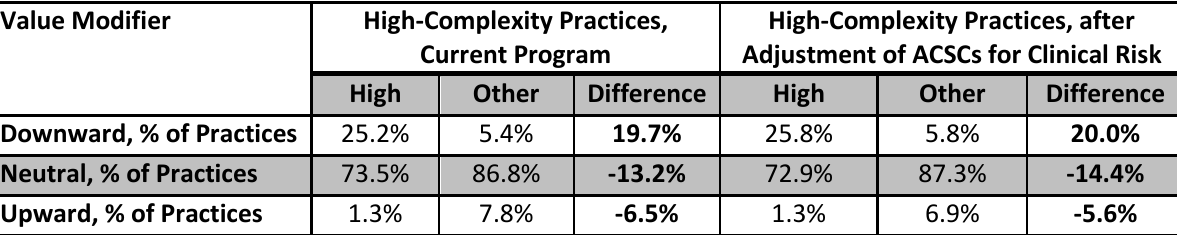
Table 10.19b. Impact on High-Complexity Practices of Adjusting ACSCs for Clinical Risk Value